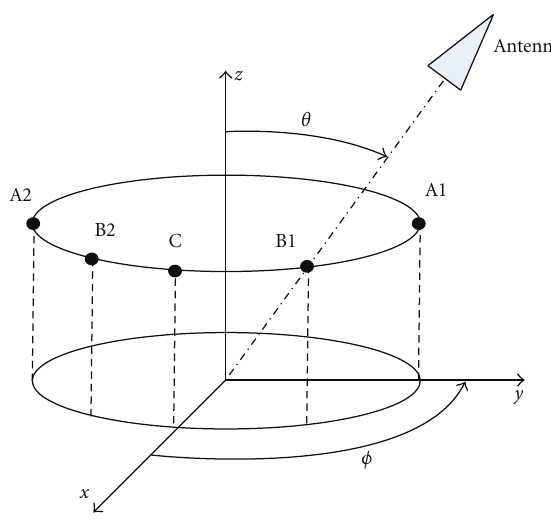
Figure 12: Geometric description of boundaries of k -space.